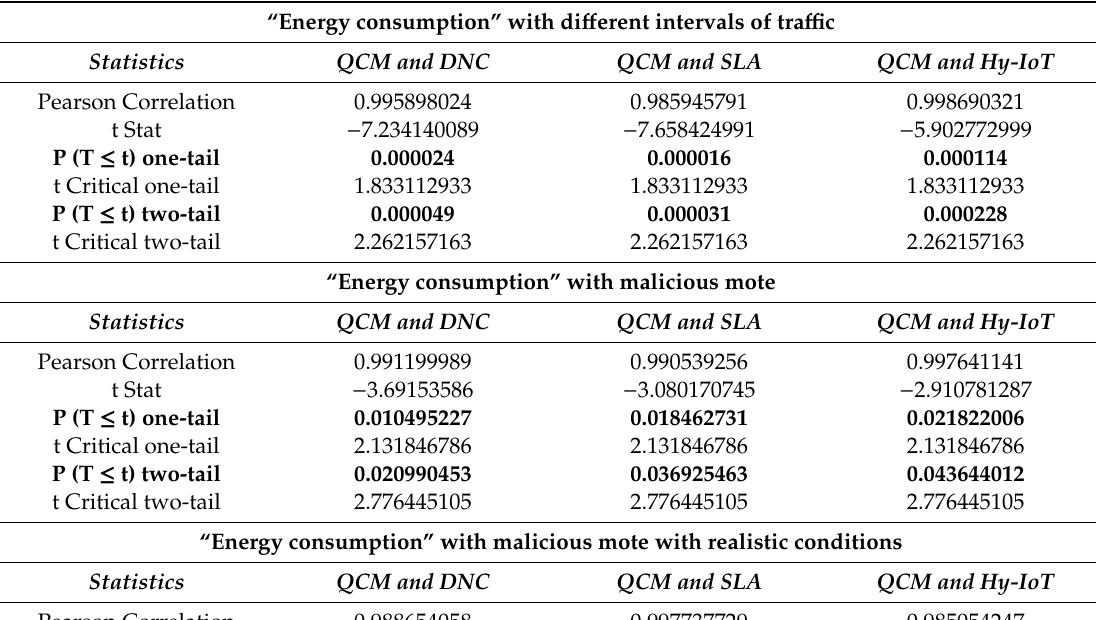
Table 2. Inferential analysis of the proposed QCM algorithm in terms of energy consumption